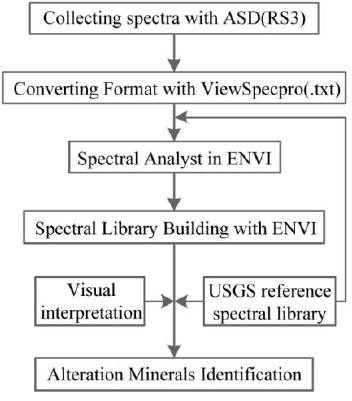
Figure 4. Processing workflow to analyze the drill core’s hyperspectral data.